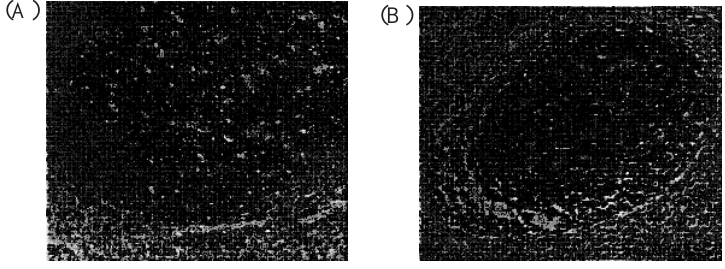
Fig. 4. Section of human tonsil stained for CD20 positive cells. Tissue was fixed in (A) Histochoice or (B) NBF (DAB chromogen, 100 × ). NBF produced a more intense